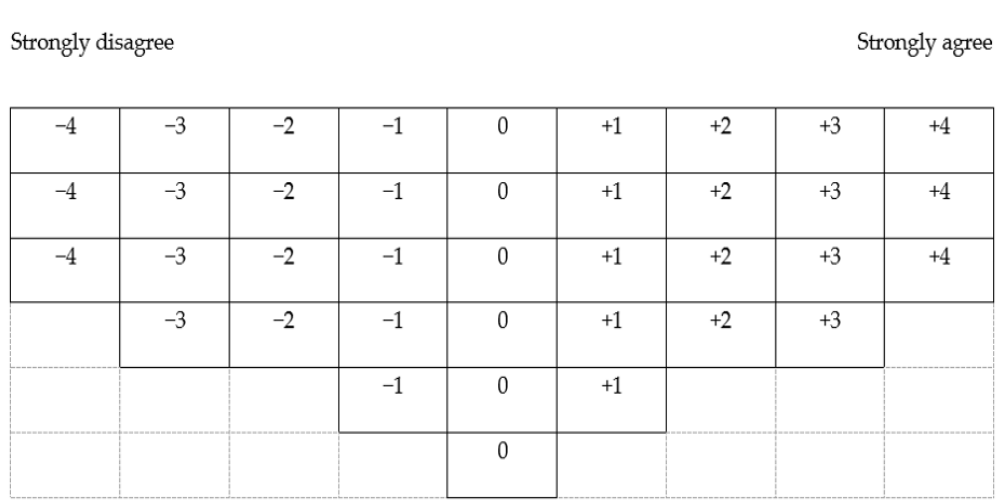
Figure 2. Q sorting table for Q sample (38 statements).